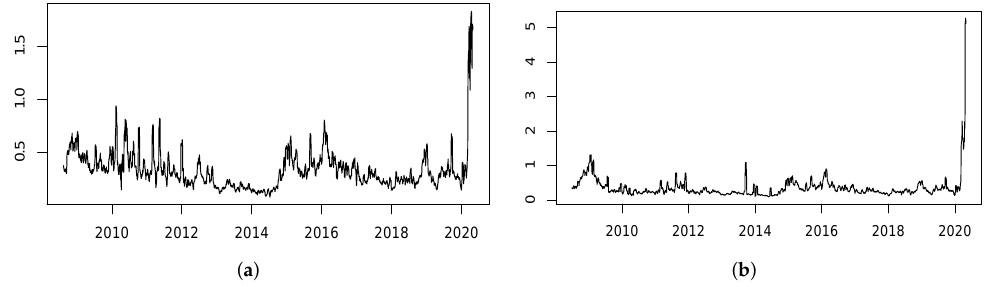
Figure 2. Volatility of BRE and WTI: 2008–2020. ( a ) BRE. ( b ) WTI. Note: this figure presents the estimated volatility of the BRE and WTI returns over 2008–2020 via the Yang and Zhang [4]